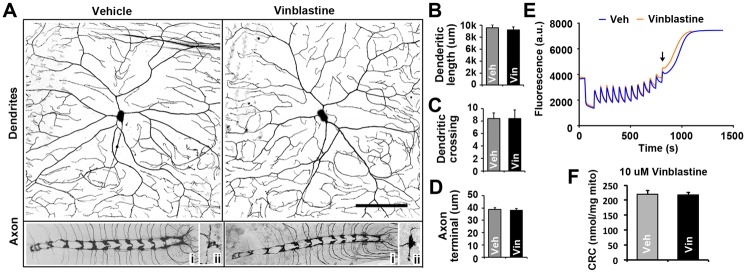
Acute exposure to vinca alkaloids has no effect on C4da sensory neuron morphology or mitochondrial toxicity.A, Confocal images of dendritic arbors, axonal projections (i), and axonal nerve terminals (ii) from C4da neurons in larvae fed vinblastine (10 μM) or vehicle for 1 hr prior to imaging. B-C, Morphometric analysis reveals no significant effects of vinblastine (black bars) on total dendritic length (A), dendritic crossing (B), and axonal terminal length (C) compared to C4da neurons incubated with vehicle (gray bars). Bars represent average values. Error bars = SEM, n = 10 dendrites; 17–20 nerve terminals. E, Representative recording showing the calcium overload required to induce mPTP opening (arrow) in isolated mitochondria. F, Bar graph showing no significant differences in the calcium retention capacity (CRC) of isolated mitochondria treated with 10 uM vinblastine (black bar) compared to vehicle (gray bar). Bars represent average values. Error bars = SEM, n = 7 animals for each condition.